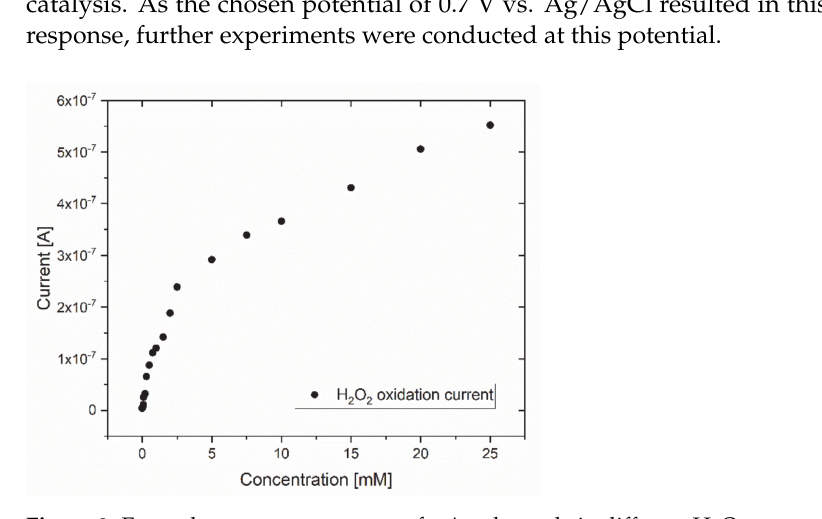
Figure 2. Exemplary current response of a Au electrode in different H 2 O 2 concentrations. The trend showed an increasing current response with increasing H 2 O 2